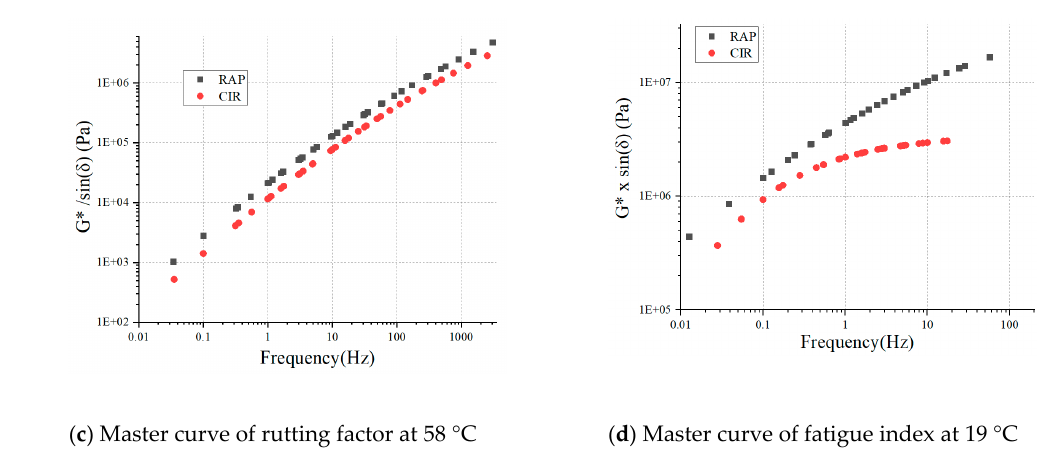
Figure 13. DSR test results for RAP and CIR asphalt: ( a ) The complex modulus of asphalt binder at 58 °C; ( b ) master curve of phase angle at 58 °C; ( c ) master curve of rutting factor at 58 °C; ( d ) master curve of fatigue index at 19 °C.